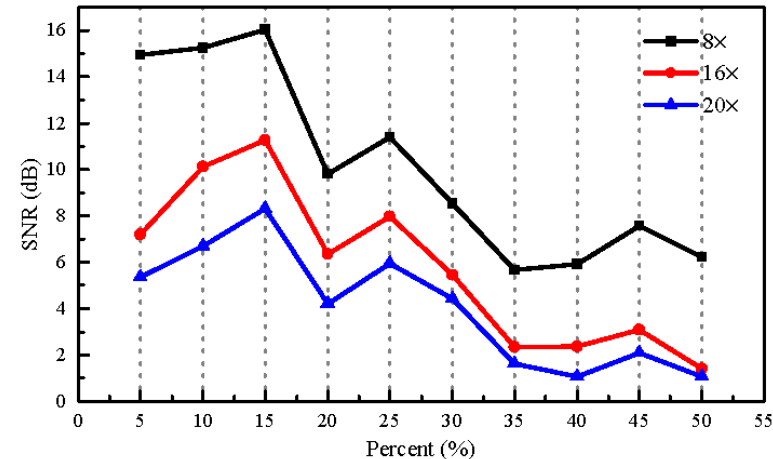
Figure 11. The dependence of the SNRs of the recovered sinusoidal sound signal on the ratio of the number of zeros to ones in each designed sampling pattern at different compressions of 8 × , 16 × , and 20 × . The frequency of the sinusoidal voltage applied to the loudspeaker is 150 Hz and the rate of CCD image recording is 100 Hz.